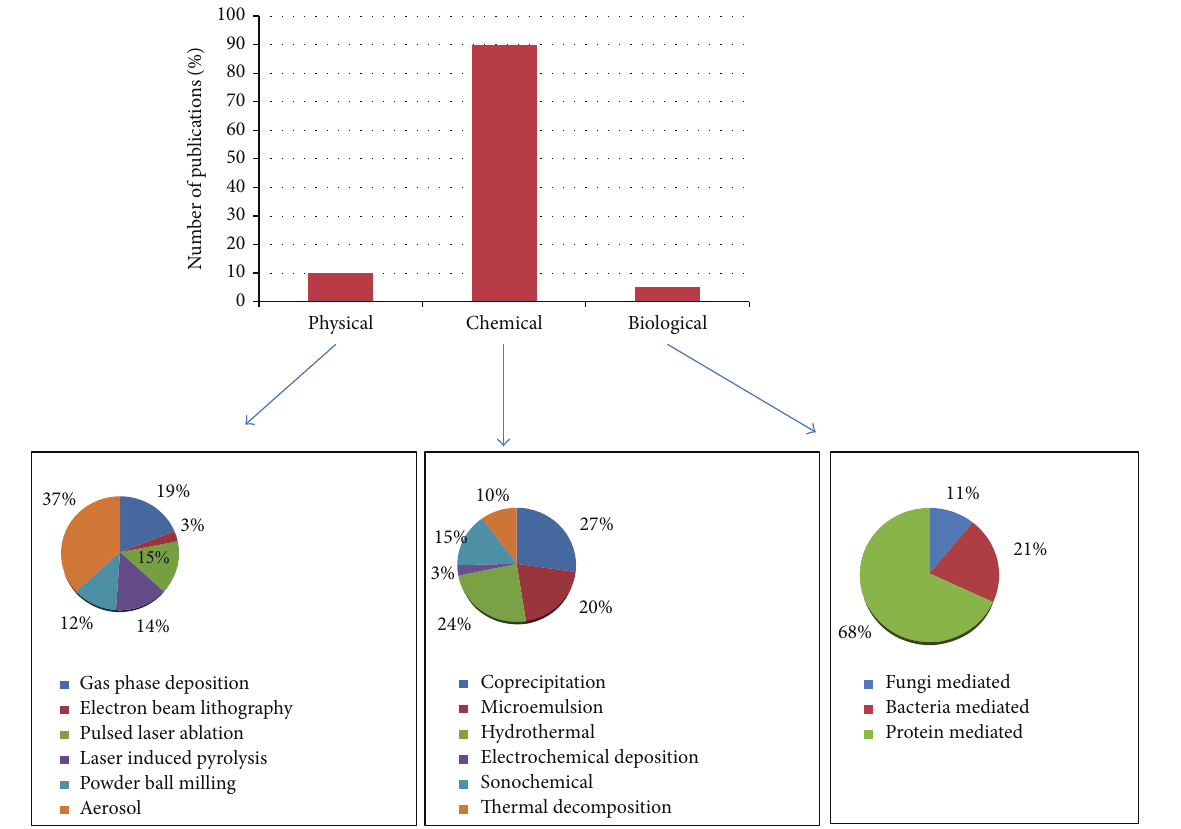
Figure 1: Synthesis of iron oxide nanoparticles by three different methods (adapted from